Question: What does this figure show? Answer in one sentence.
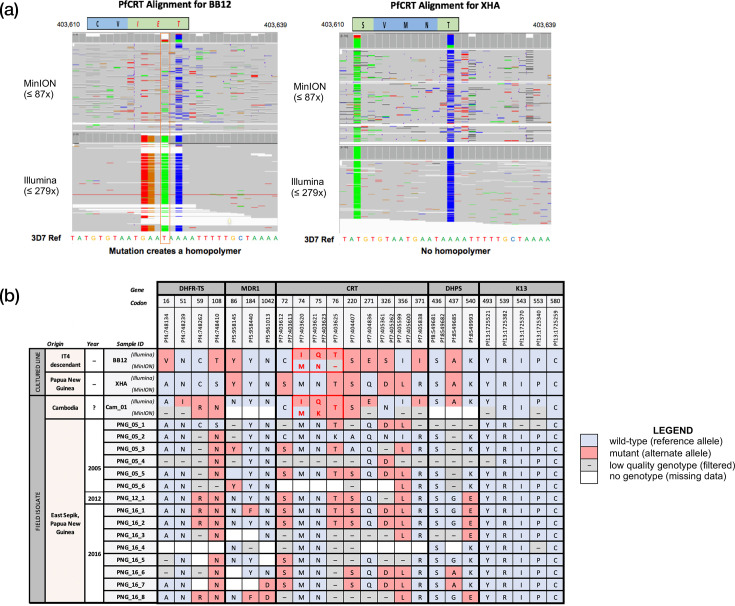
Answer: Drug resistance profiling. ( a ) Alignments of Nanopore sequence data across crt codons 72 to 76 for laboratory isolates BB12 and XHA. Nanopore and Illumina genotypes are discordant for BB12, where the mutation at position Pf3D7_07_v3:403625 has given rise to a homopolymeric tract. Nanopore and Illumina genotypes are concordant for XHA, for which there is no such homopolymeric stretch. ( b ) Drug resistance amino acid haplotypes for laboratory isolates XHA, BB12 and Cam_01 (both Nanopore and Illumina), and PNG field isolates with breadth of coverage >65% at 1× (Nanopore only). Isolates were genotyped at loci corresponding to key resistance-associated variants in genes crt , mdr1 , dhfr , dhps and k13 . Note that all CRT variants previously associated with resistance that were screened included T93S, H97Y, F145I, M343I and G353V; however, all isolates had wild-type alleles and thus are not shown. Red boxes indicate resistance-associated alleles, while wild-type alleles are indicated in blue. Missing genotypes (for which there was no sequence data) and low-quality genotypes (which were removed after quality filtration) are shown in white and grey, respectively.